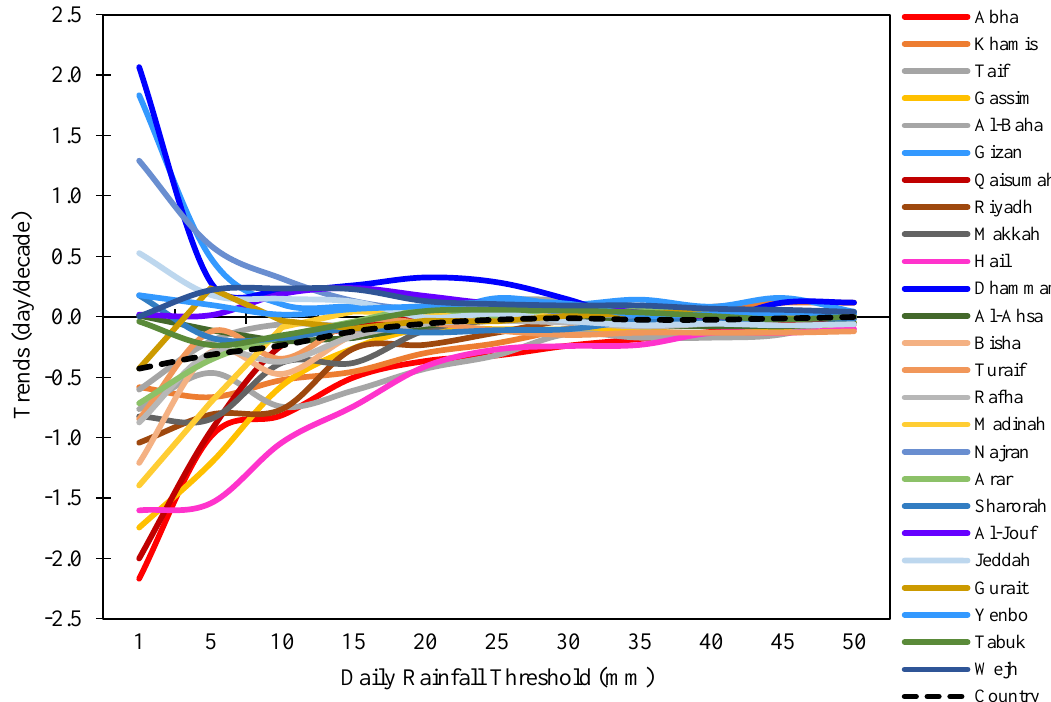
Figure 10. Extreme rainfall trends for different thresholds at each station in Saudi Arabia for the period 1978–2019.